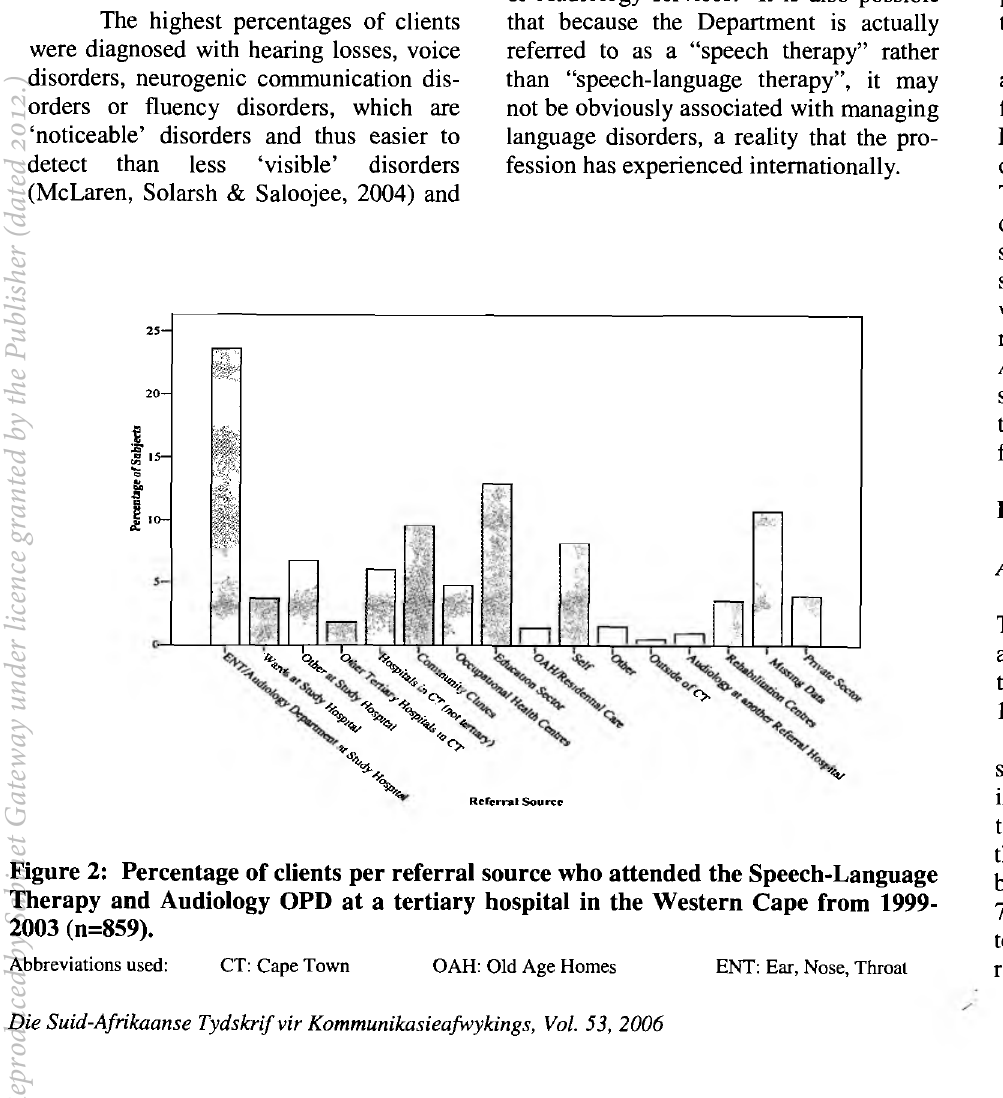
Figure 2: Percentage of clients per referral source who attended the Speech-Language Therapy and Audiology OPD at a tertiary hospital in the Western Cape from 1999- 2003